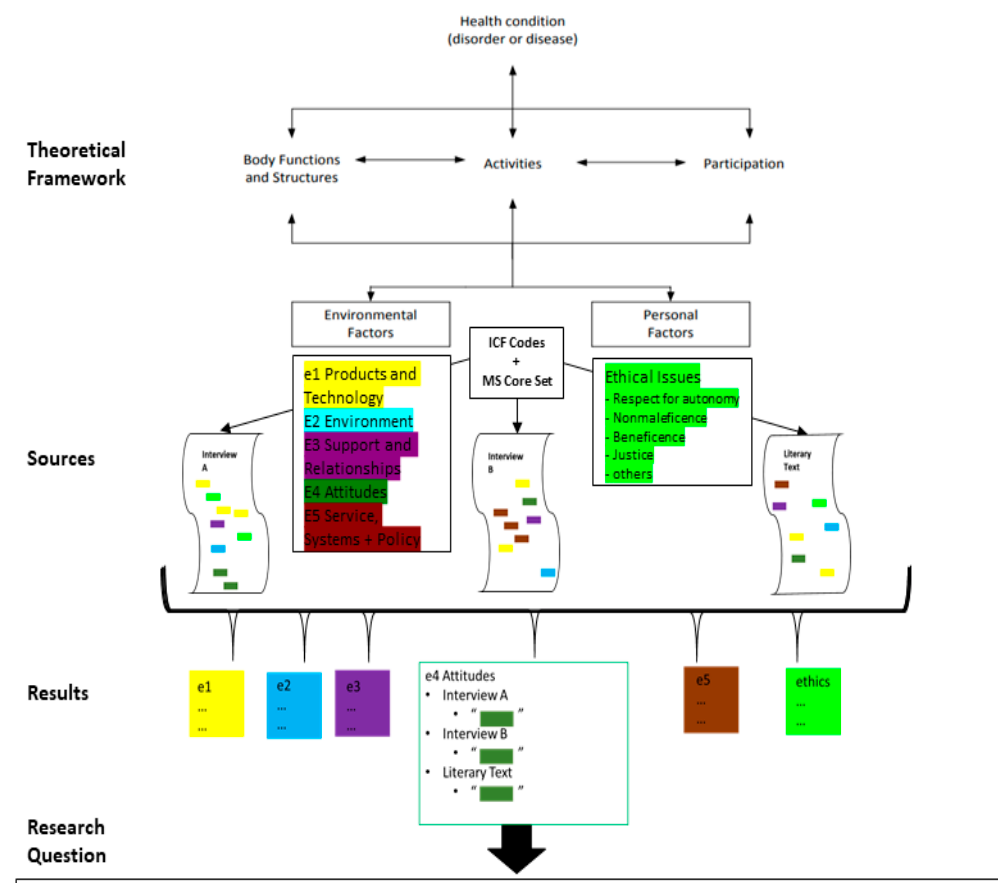
Figure 2. Flowchart and overview of paper’s methods and their integration into the theoretical framework of the bio-psycho-social model of disease and the ICF.